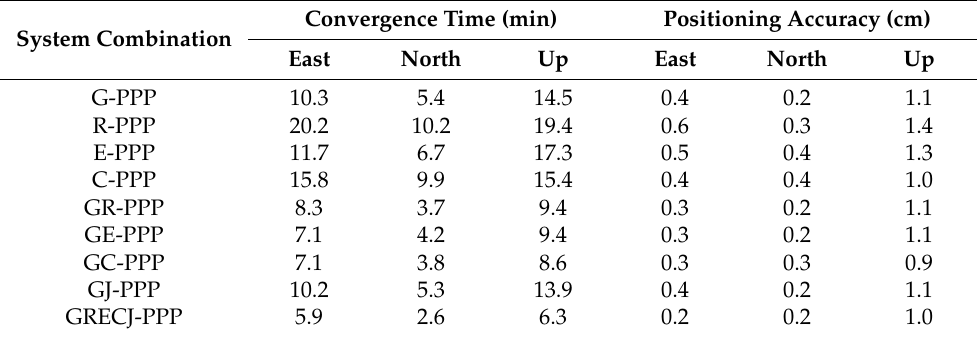
Table 11. Static positioning accuracy and convergence time of post-processed PPP (long-term perfor- mance of PPP based on daily observations) with ESA products for different system combinations using the datasets from 29 stations spanning a